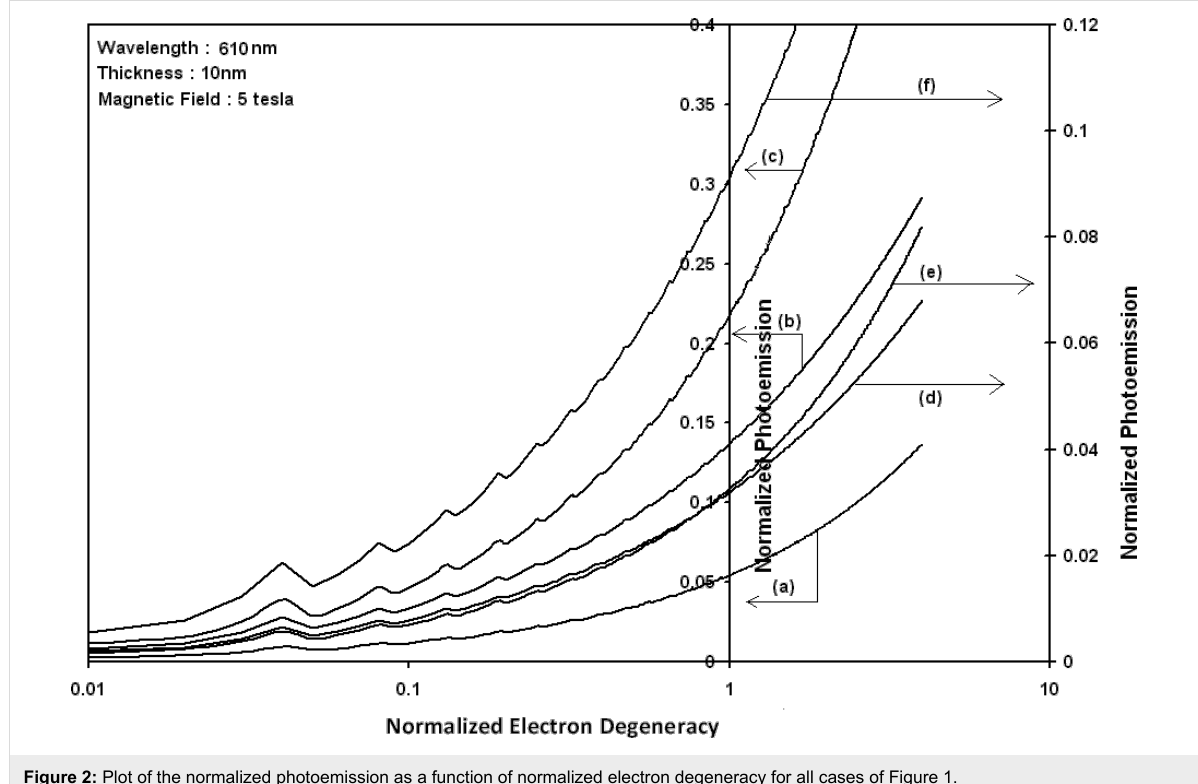
Figure 2: Plot of the normalized photoemission as a function of normalized electron degeneracy for all cases of Figure 1.